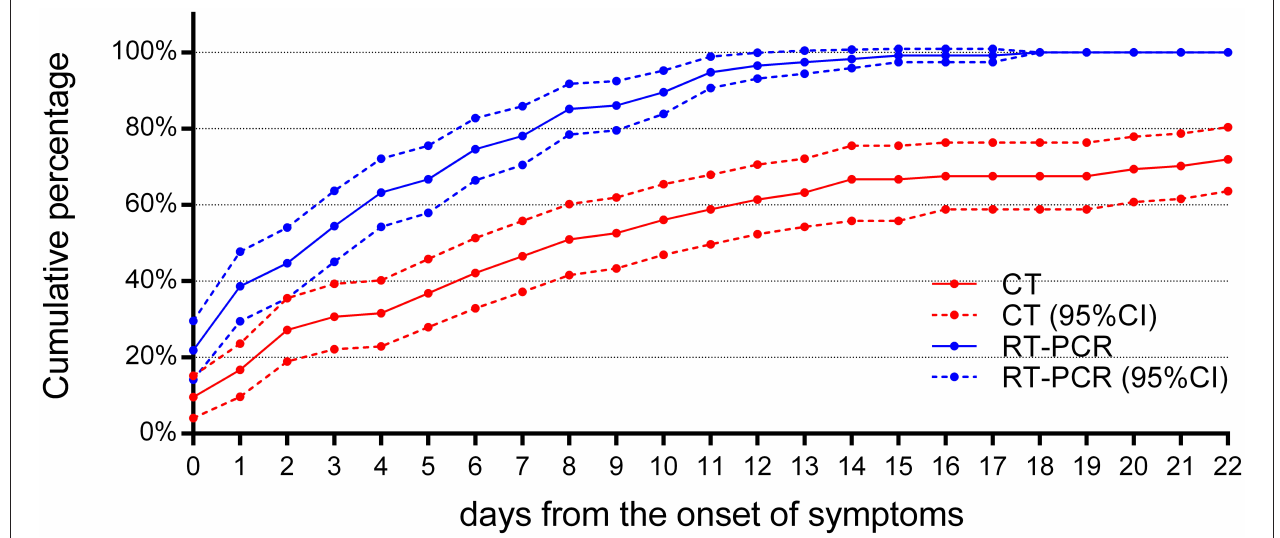
FIGURE 5 | The cumulative percentage of identified cases by RT-PCR and chest CT. Both curves of RT-PCR and CT increased rapidly after the onset of symptoms ( n = 114). By the 7th day after the onset of symptoms, 89 (78%) cases have been confirmed by RT-PCR, compared to 53 (46%) cases by chest CT ( P < 0.05). By day 14 after the onset of symptoms, RT-PCR diagnosed 112 (98%) cases, but chest CT was positive in only 76 (67%) cases ( P < 0.05). 95% CI, 95% confidence interval.